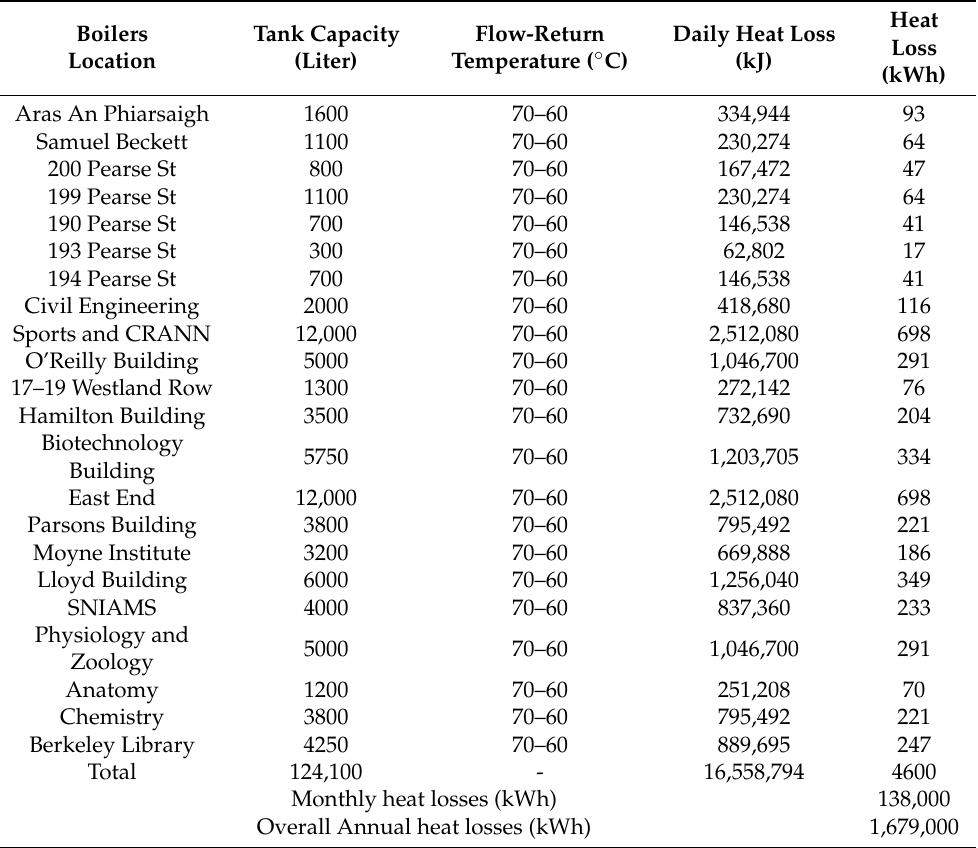
Table 2. The calculated heat loss of boilers at TCD